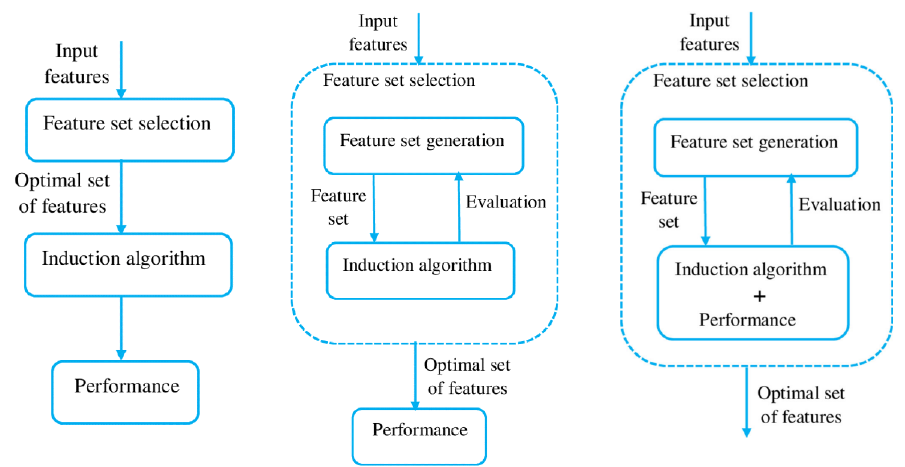
Figure 3. Flowchart of the FS process in different FS categories: Filter, Wrapper, Embedded